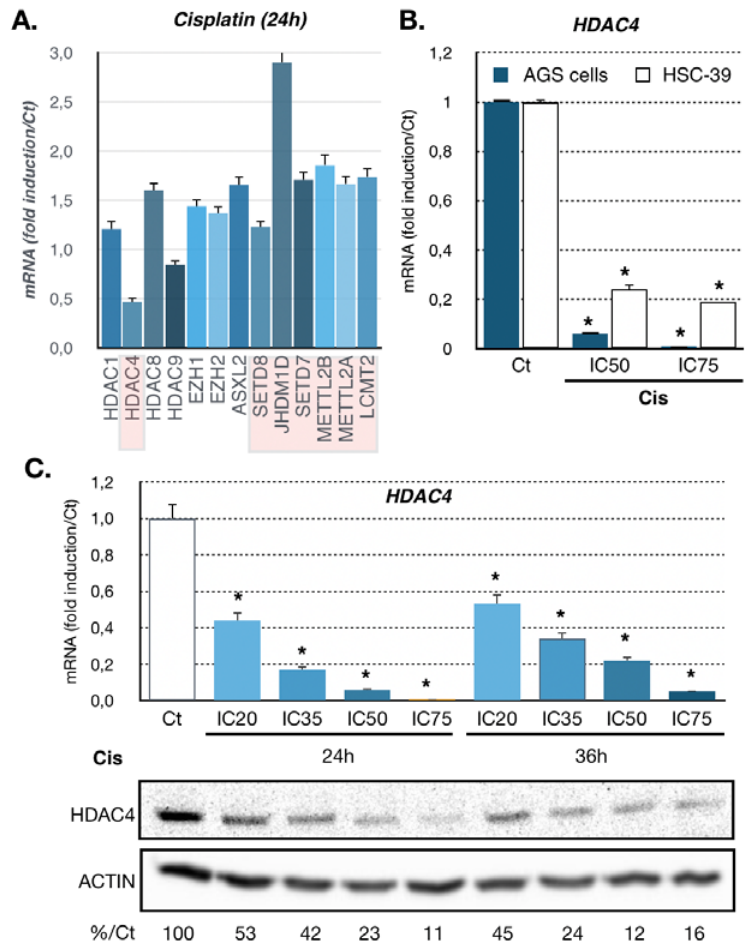
Figure 1. Regulation of HDAC4 expression in gastric cancer in response to cisplatin. ( A ) Genes encoding epigenetic modulators deregulated in response to cisplatin treatment. The graph represents fold change (treated / not-treated) obtained after microarrays analysis of U87 cells treated for 24 h with cisplatin (IC 50 ) or not treated control ( p < 0.05). Deregulated genes identified by statistical di ff erence ( p < 0.05) were analyzed by bioinformatics for unsupervised pathway and mechanism clustering. ( B ) Expression of HDAC4 in gastric cancer cell lines treated with cisplatin. HDAC4 mRNA level was assayed in AGS (Wt p53) and HSC39 (p53 G245S) cells by RT-qPCR. Cells were treated at the IC 50 and IC 75 of cisplatin (Cis) for 24 h. Bars are means of fold induction versus the control (Ct) and the indicated cisplatin concentration ( µ M). *, p < 0.001 ( n = 3), compared with the control, as calculated by one-way ANOVA test followed by a Tukey post-test. ( C ) Expression of HDAC4 in AGS cell line treated with cisplatin for 24 and 36 h. HDAC4 mRNA level was assayed in AGS cells by RT-qPCR. Bars are means of fold induction versus the control (Ct). *, p < 0.001 ( n = 3), compared with the control, calculated by one-way ANOVA followed by a Tukey post-test. Proteins from AGS cells treated or not (Ct) for 24 and 36 h with the indicated concentrations of cisplatin (IC 50 , IC 75 ) were separated on an SDS PAGE gel and propped with an HDAC4 specific antibody. Numbers at the bottom state in % the